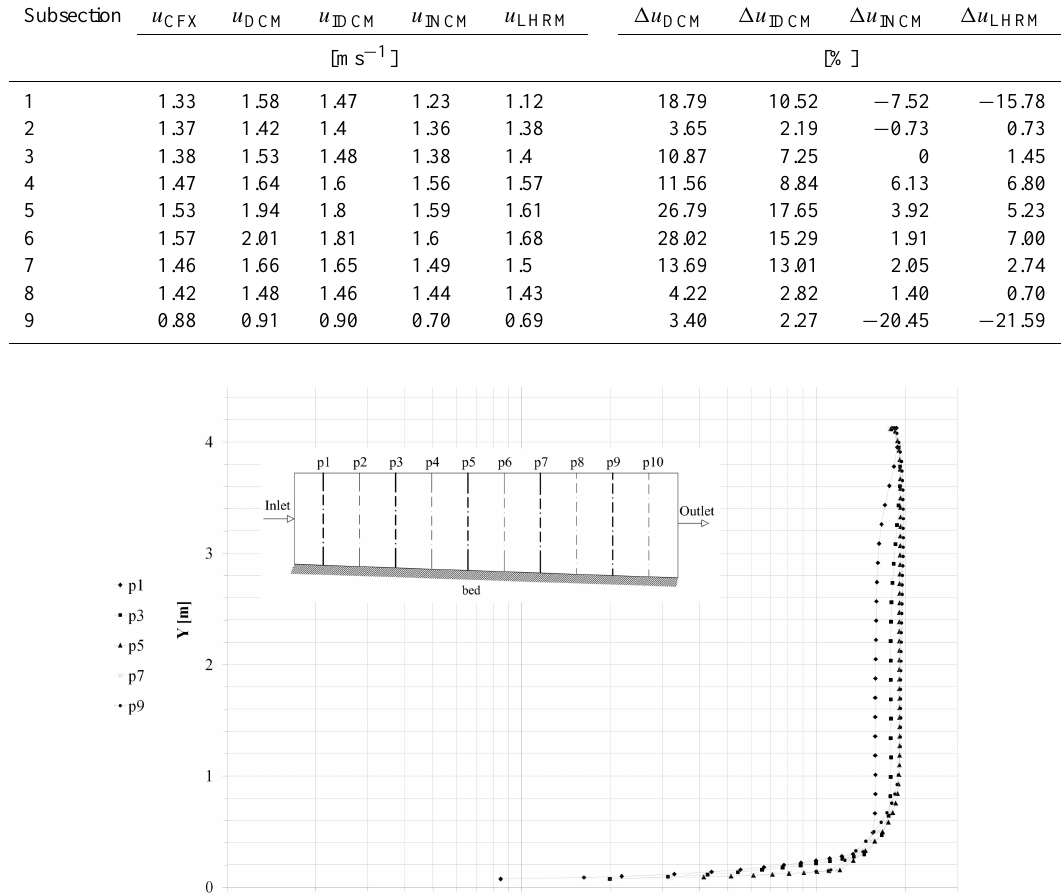
Figure 14. Streamwise vertical profile along the longitudinal axis of the mean channel.